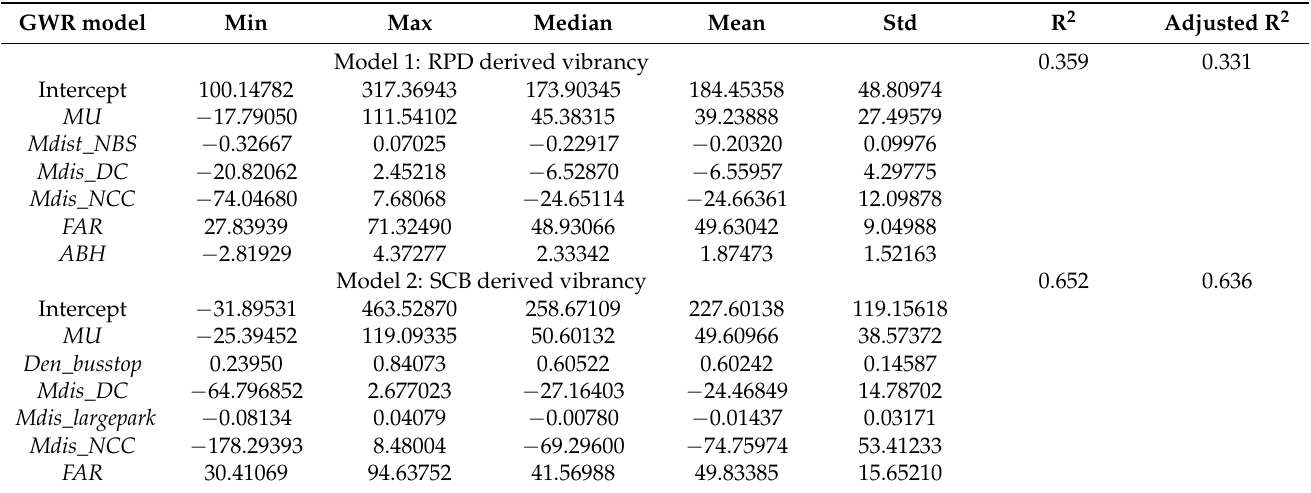
Table 5. Calculation results of geographical weighted regression (GWR)